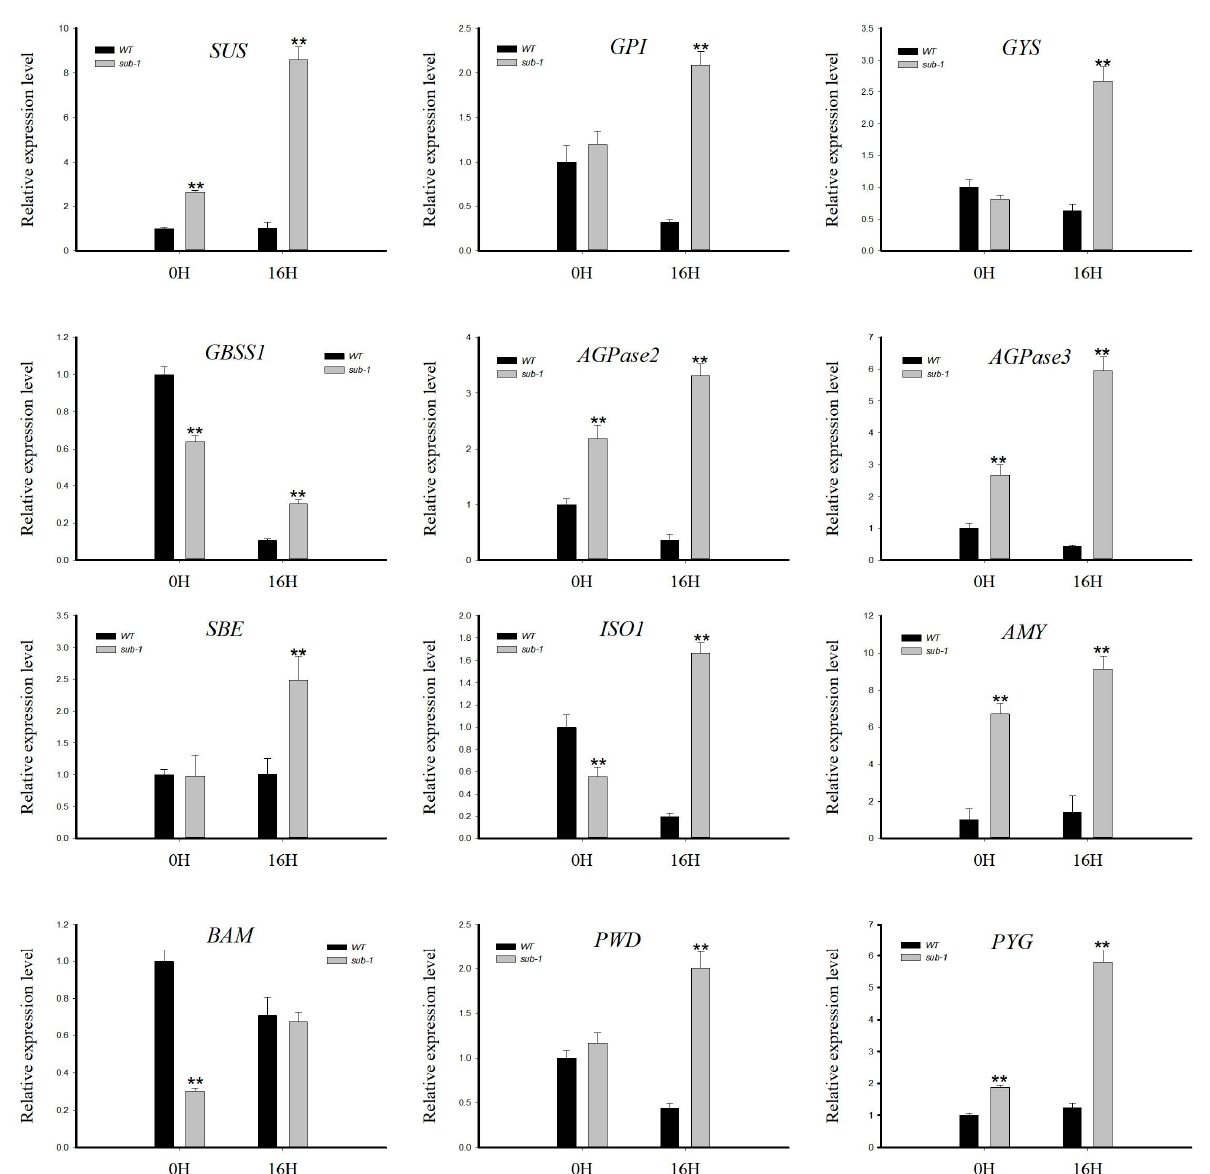
Figure 6. Transcriptional expression analysis of key enzyme genes in starch and sucrose metabolic pathways. SUS : sucrose synthase, GPI : glucose-6-phosphate isomerase, GYS : glycogen synthase, GBSS : granule-bound starch synthase, ADPase2 : ADP-glucose pyrophosphorylase 2, ADPase3 : ADP-glucose pyrophosphorylase 3, SBE : starch branching enzyme, ISA1 : isoamylase 1, AMY : α -amylase, BAM : β -amylase, PWD : phosphoglucan-water dikinase, PYG : glycogen phosphorylase. Bars represent standard deviations (SD) from three biological replicates. Asterisks indicate the significant difference between wild type and sub-1 mutant (** p < 0.01) using Duncan’s test.